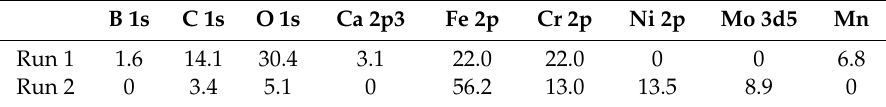
Table 2. A comparison of the chemical composition of SS316 / 0.25%BN sample obtained from the X-ray photoelectron spectroscopy (XPS) data analysis (see Supplementary Information Figure S3). B